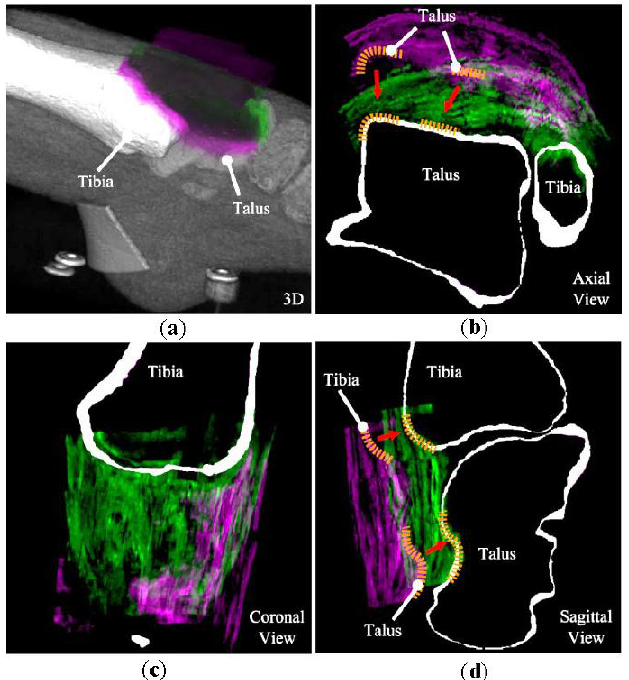
Figure 5. A visualization of one of the successful registrations achieved in Test I. ( a ) the 3D view ( b ) Axial view ( c ) Coronal view and ( d ) Sagittal view. US volume in purple color represents the data at initialization position prior to registration. US volume in green depicts the result of the registration. Dashed lines in yellow highlight the contours of the tibia and talus observed in both axial and sagittal views. Arrows in red shows that US volume goes from its initial position (i.e., US volume in purple) to its final position (i.e., US volume in green).